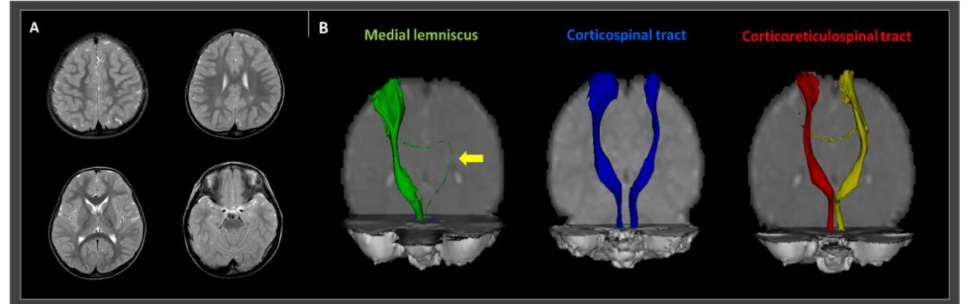
Figure 1. T2-weighted magnetic resonance imaging and diffusion tensor tractography (DTT) images of a 27-month old male cerebral palsied patient with gait instability. ( A ) T2-weighted magnetic resonance images show no abnormal lesions. ( B ) DTT revealing a thinned and disrupted left medial lemniscus (yellow arrow). However, the right medial lemniscus and both the corticospinal and corticoreticulospinal tract show preserved integrity to the cortex.